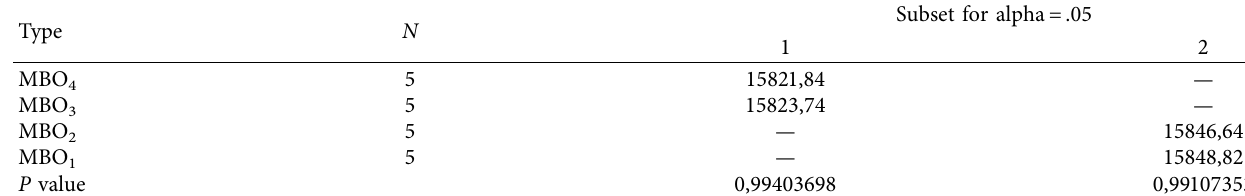
Table 7: Tukey’s test for the d198